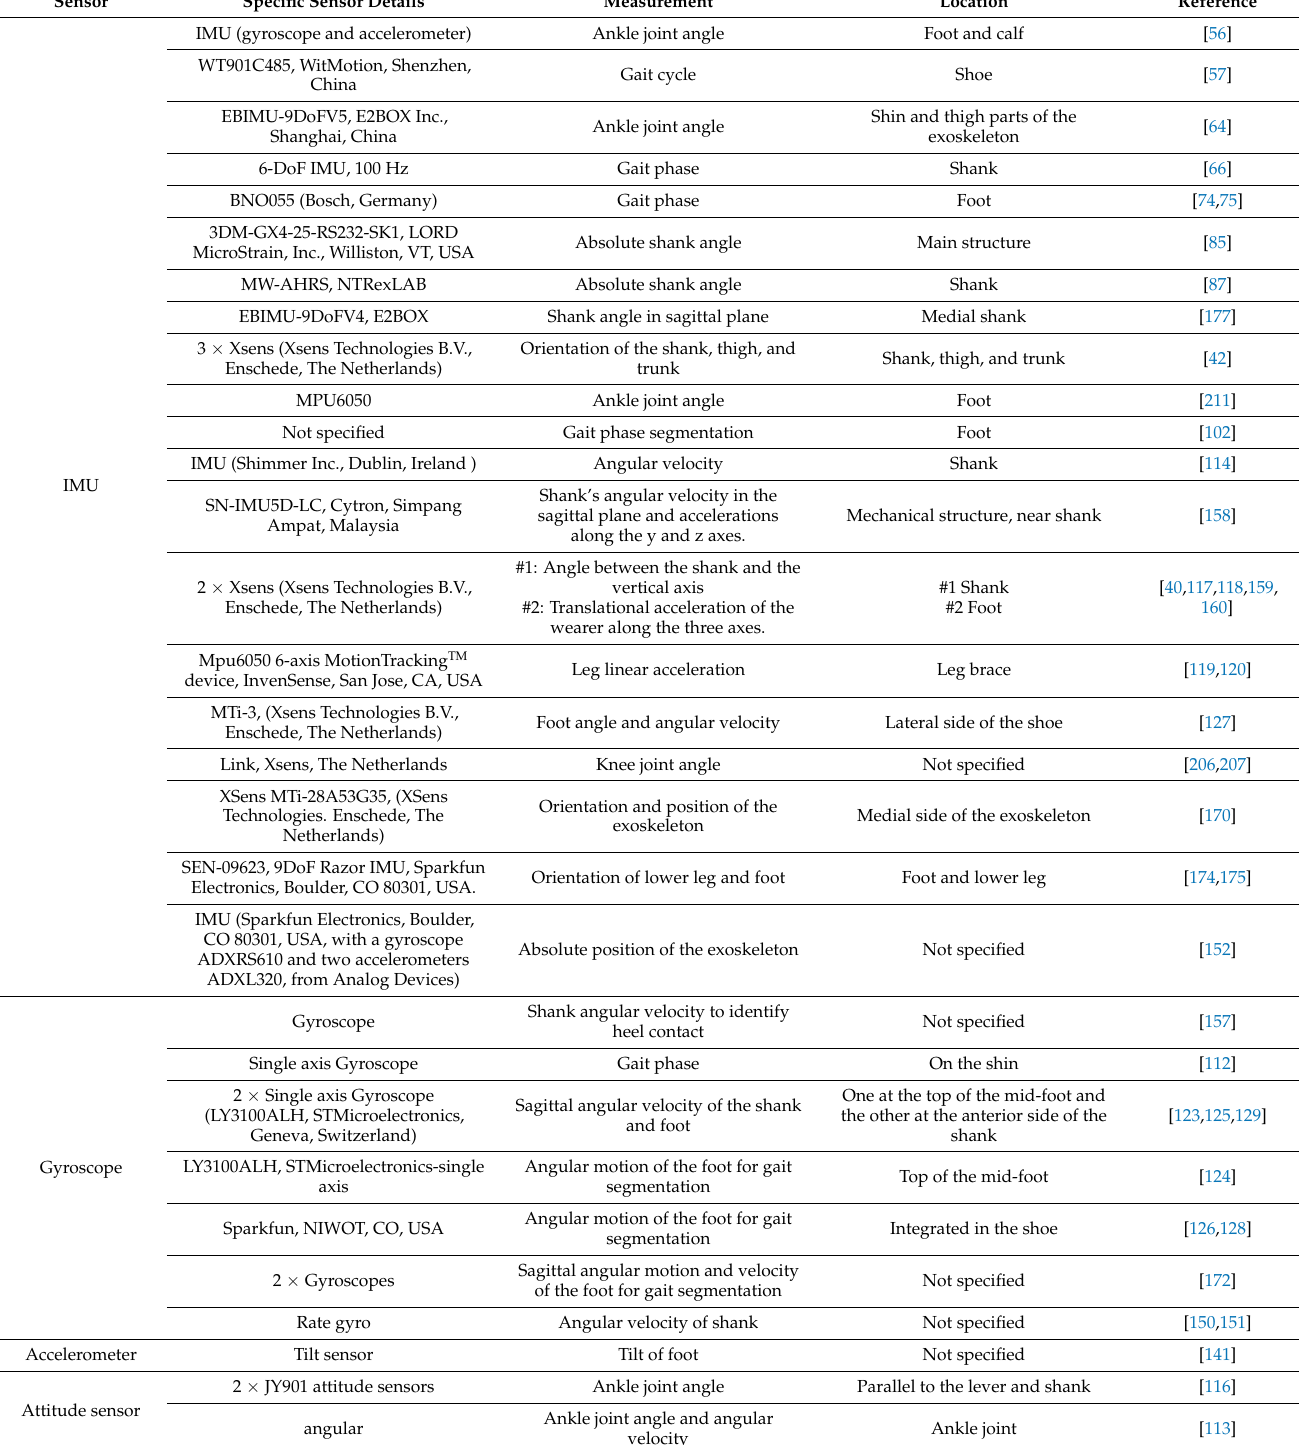
Table 4. Detailed technical information of different human–machine interface sensors used in the reviewed PAEs including the specific sensor type, measured parameter, and sensor placement